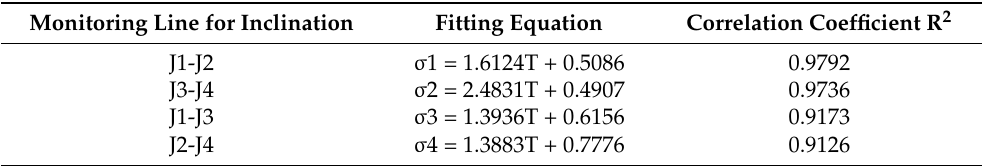
Table 4. Fitting equation and correlation coefficient between the peak tensile stress on the upper surface of the main beams and the inclination of the shaft tower foundation. Monitoring Line for